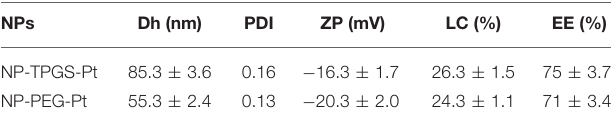
TABLE 1 | Characterization of DACHPt-loaded